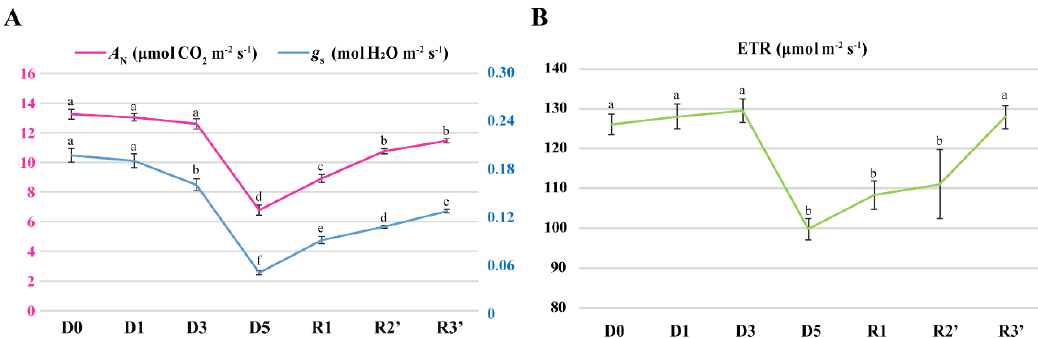
Figure 5. Photosynthesis characteristics analyses. ( A ) Analysis of net photosynthesis rate ( A N ) and stomatal conductance ( g s ). ( B ) Analysis of rate of linear electron transport (ETR). D0: no-drought stress, D1–D5: 1 d–5d of drought treatment, R1: re-watered for 8 h; R2’: re-watered for 32 h; R3’: re-watered for 56 h. Values are expressed as means ± SE, n = 5. Statistically different values ( p < 0.05) are indicated by different letters.